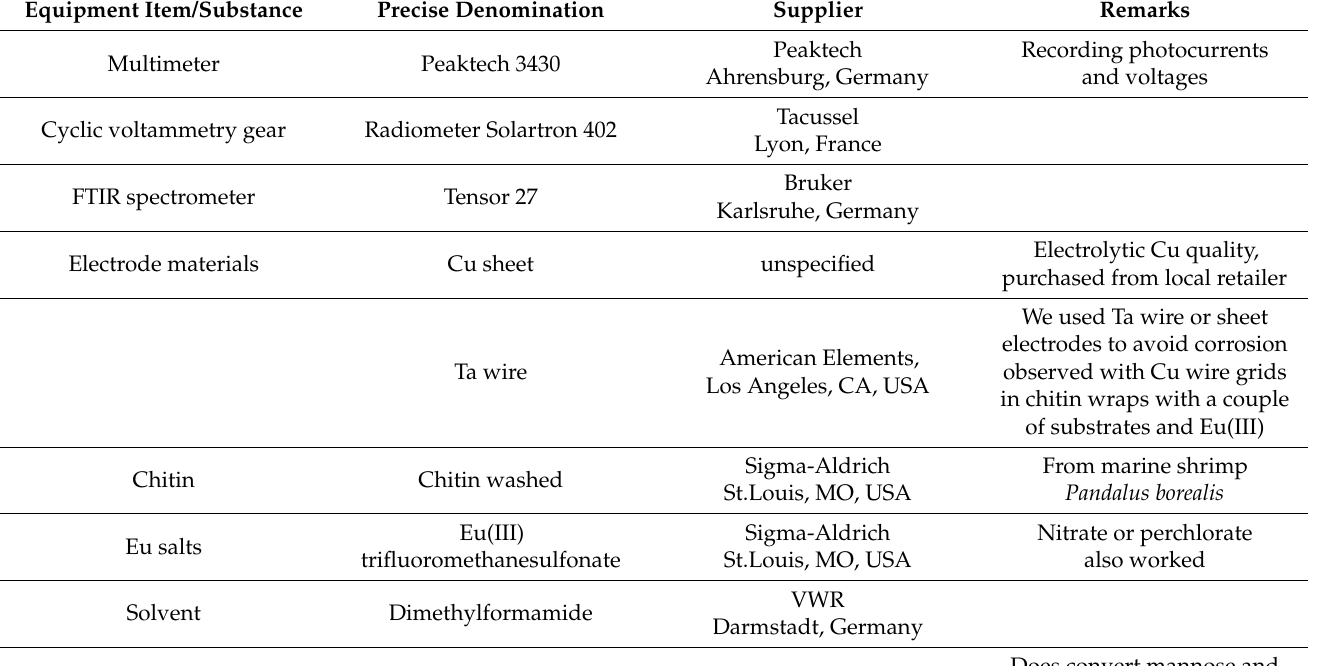
Table 1. Devices and substances used in this